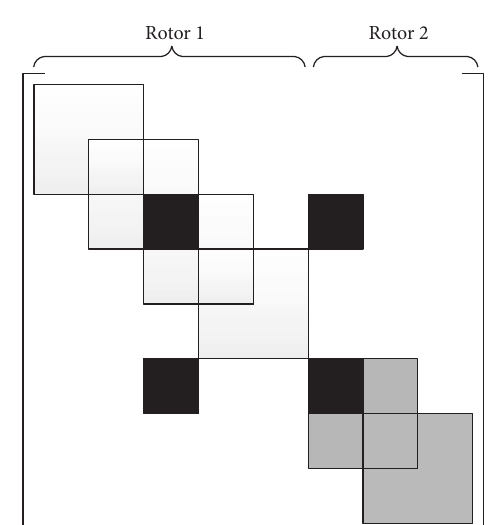
Figure 4: Structure of the entire assembled equation for a geared